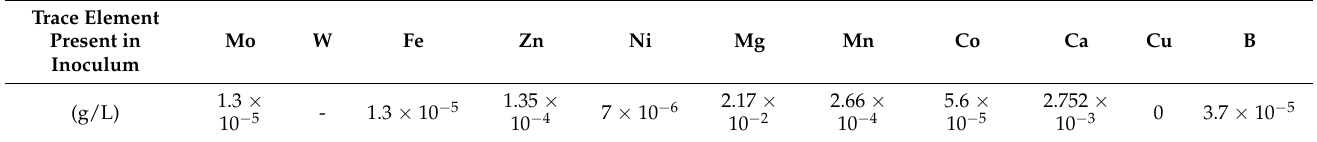
Table 1. ICP analysis result of the inoculum.